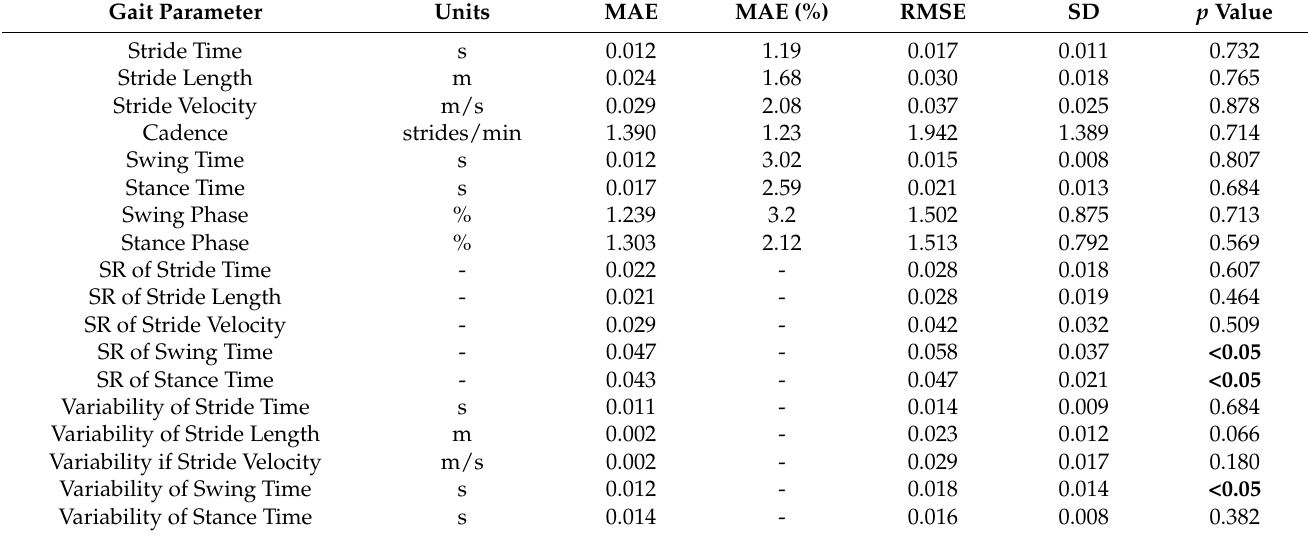
Figure 11. Histogram of error distribution of eight parameters for validation: stride time, stride length, swing time, stance time, velocity, cadence, swing phase, and stance phase. Table 3. Accuracy and precision of Nushu estimated spatiotemporal gait